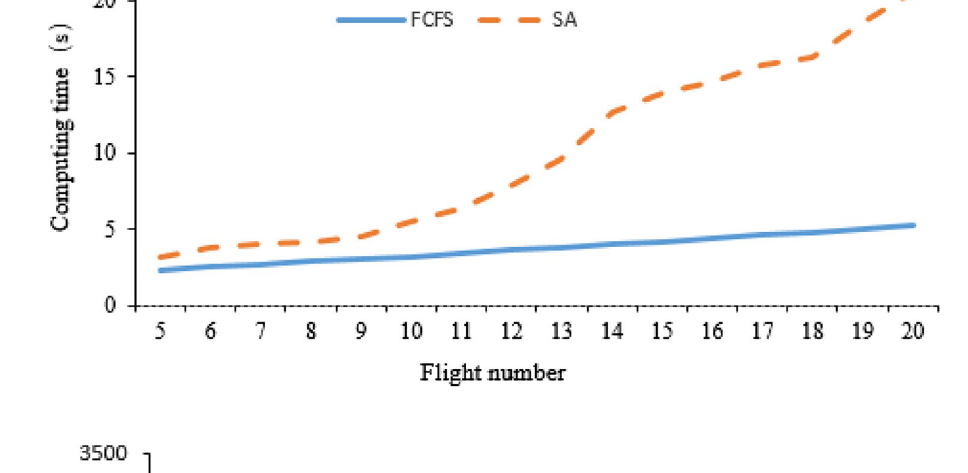
Fig. 5 The total delay time of FCFS and